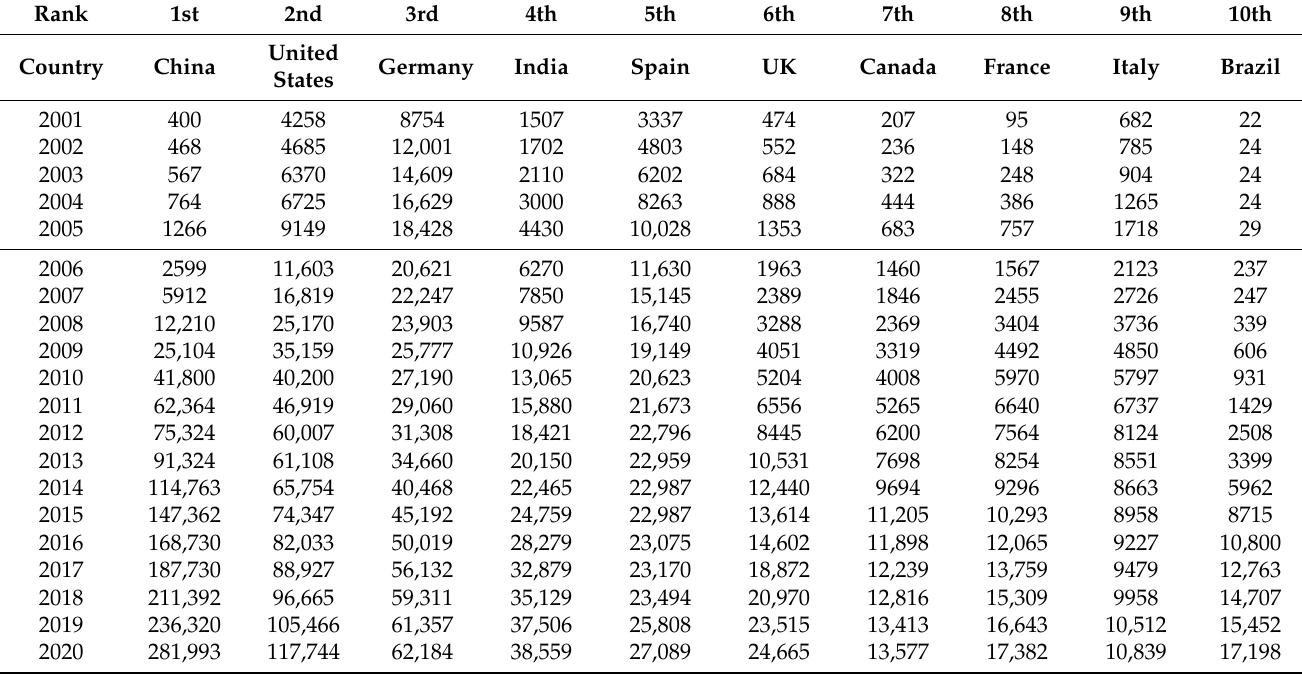
Table 3. Wind power installation capacities of the world’s major countries on a year-by-year basis (MW, in the end of 2020). Source: The wind power; wind farms and wind turbines database